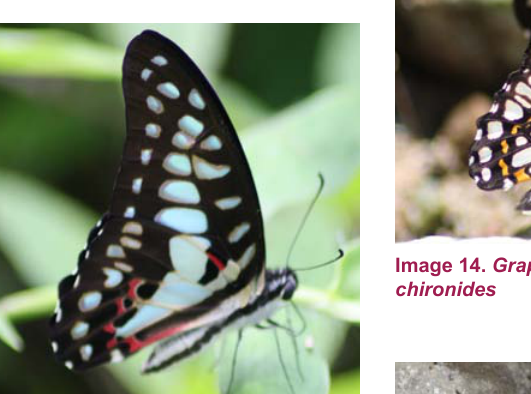
Image 12. Graphium evemon albociliatis